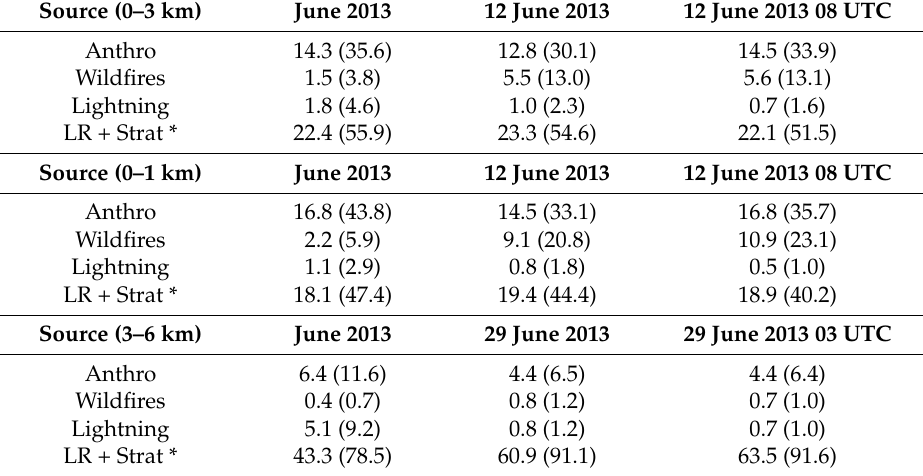
Table 2. GEOS-Chem-predicted source-specific O 3 magnitude † (percent contribution to total O 3 ) for monthly-averaged model predictions, daily-averaged values for 12 and 29 June 2013, and hourly-averaged values for 08 UTC on 12 June 2013 (between 0–1 km and 0–3 km) and 03 UTC on 29 June 2013 (between 3 and 6 km).